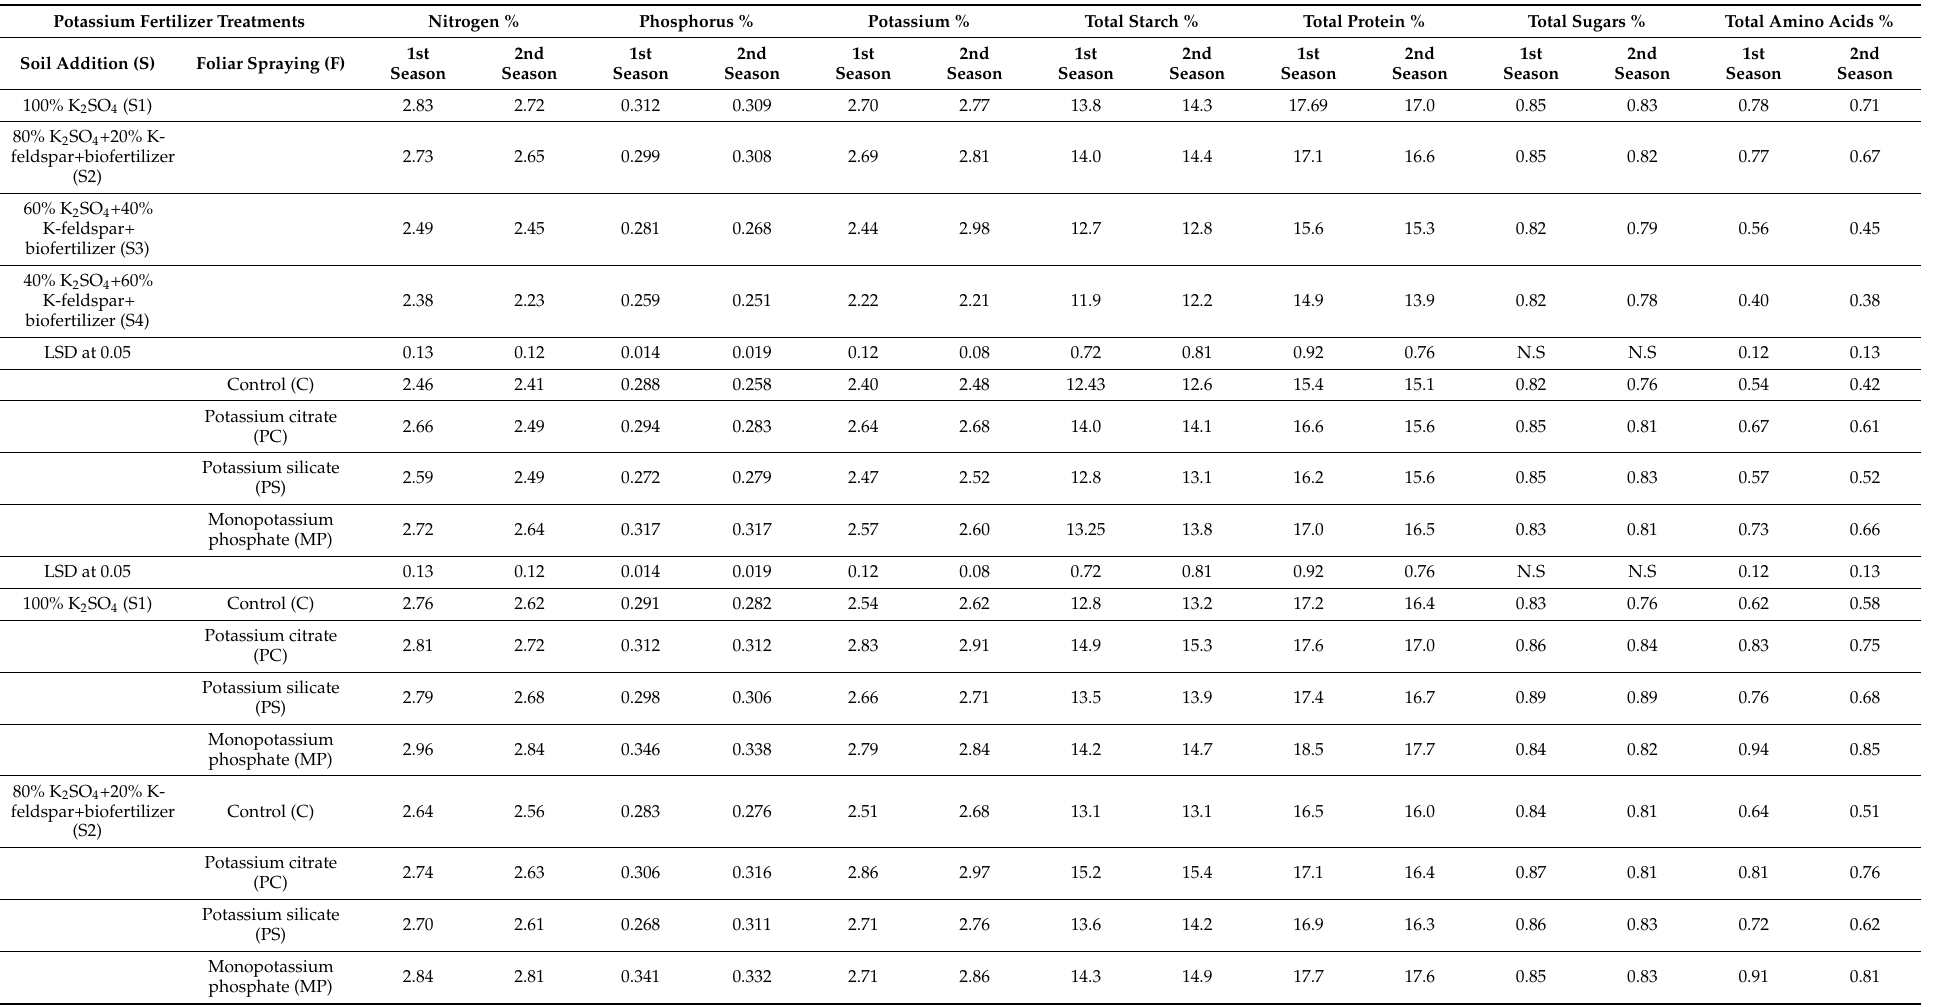
Table 6. The effect of potassium fertilization with soil addition (S) or foliar spraying (F) on tuber chemical composition during the 2018 and 2019 growing seasons (results are expressed on a dry weight